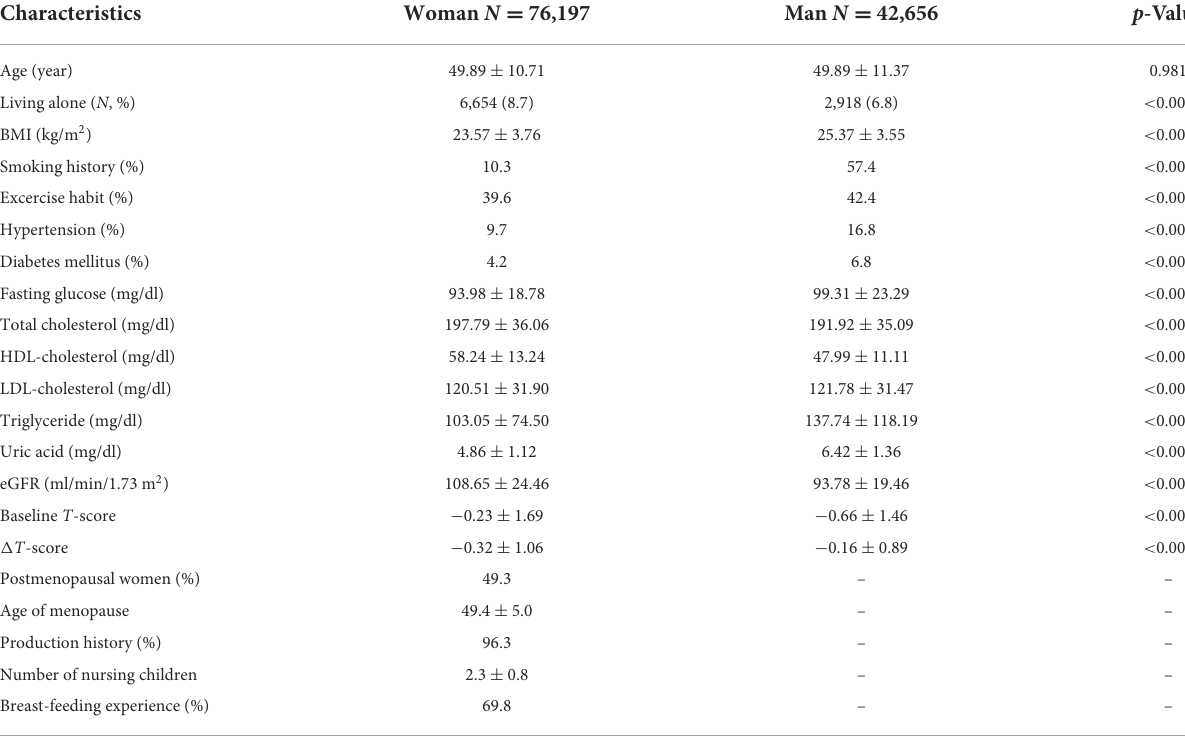
TABLE 2 Comparison of clinical characteristics among men and women.